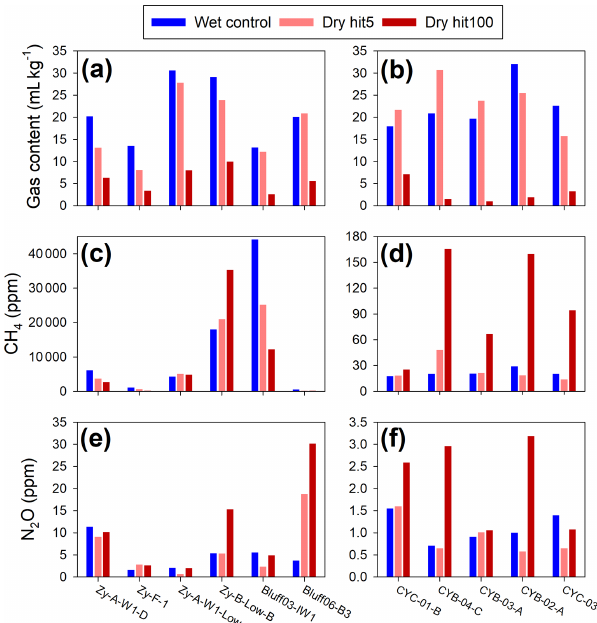
Figure 2. Results of dry extraction tests with 5 and an additional 100 hits to ice-wedge samples, denoted as “hit5” and “hit100”, re- spectively (c–f) . Also plotted are gas content results from both ex- periments, where the hit100 values are given in units of millilitre per kilogram (mLkg − 1 ) at STP conditions ( a and b ). It should be noted that the hit100 gas content results indicate the additional amount of gas extracted after hit5 crushing and